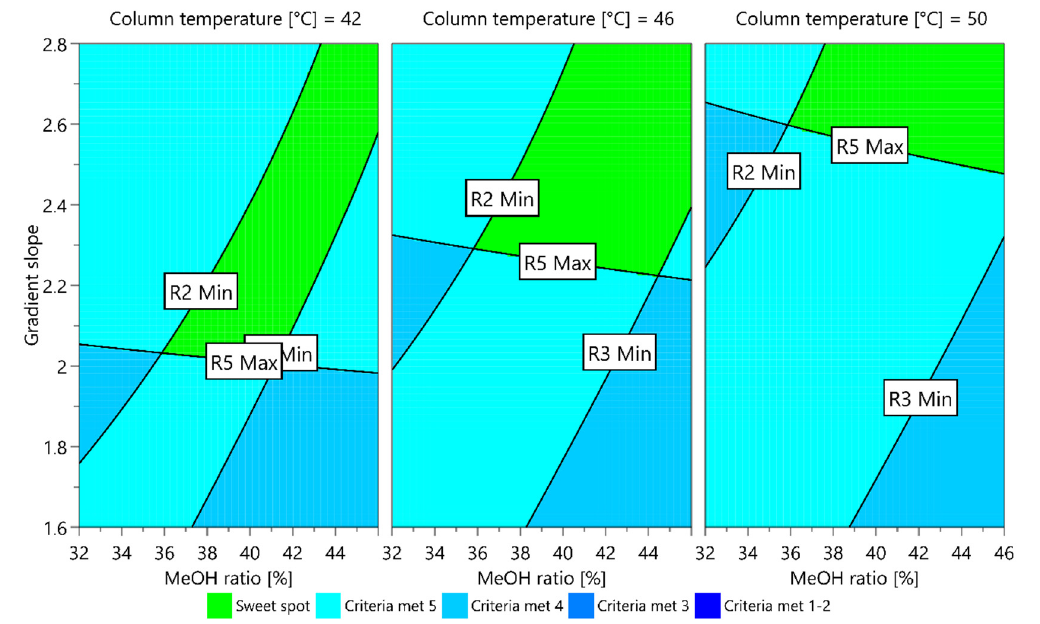
Figure 5. Sweet spot plot obtained for a central composite face-centered design MLR fitted model when unknown degradation impurity is eluting after impurity C. The green field is a sweet spot where all CMA criteria are met.